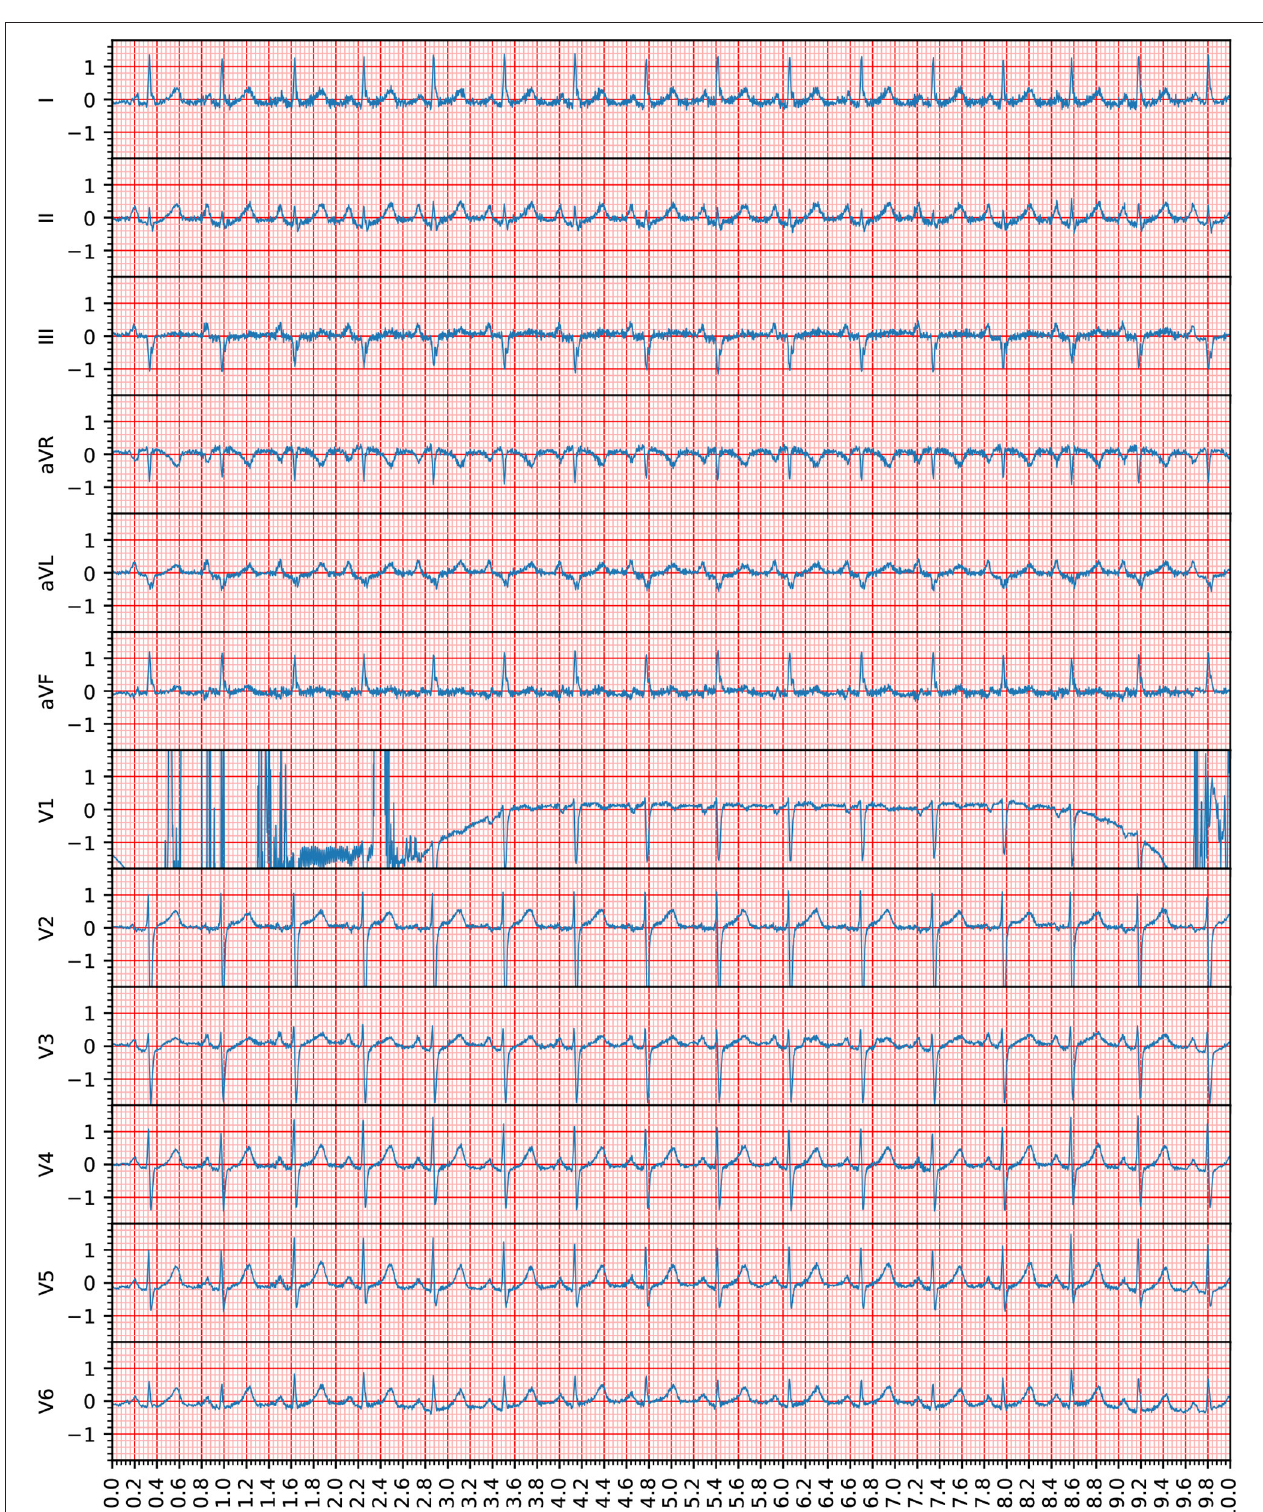
FIGURE 1 | This recording (Recording 1609343) was annotated as being of unacceptable quality in the PhysioNet/Computing in Cardiology Challenge. However, according to the assessment in this study, only Lead V1 was unacceptable because the heartbeats provided by this lead were not clearly recognizable. The voltage ( y axis) is given in 100 micro volts, the time ( x axis) is given in seconds. Note that the 12-lead ECG signals are visible in the standard ECG grid to improve the clinical interpretation of the ECG waveforms.